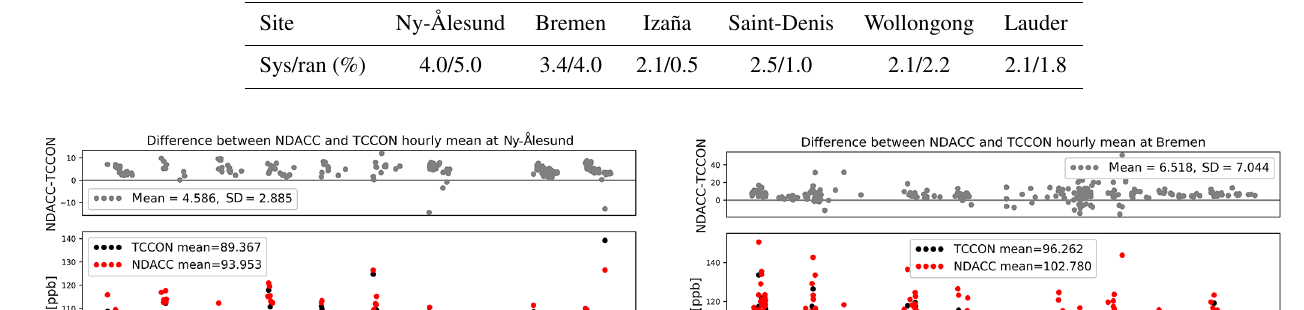
Table 3. The systematic and random uncertainties of NDACC retrieved CO total column.